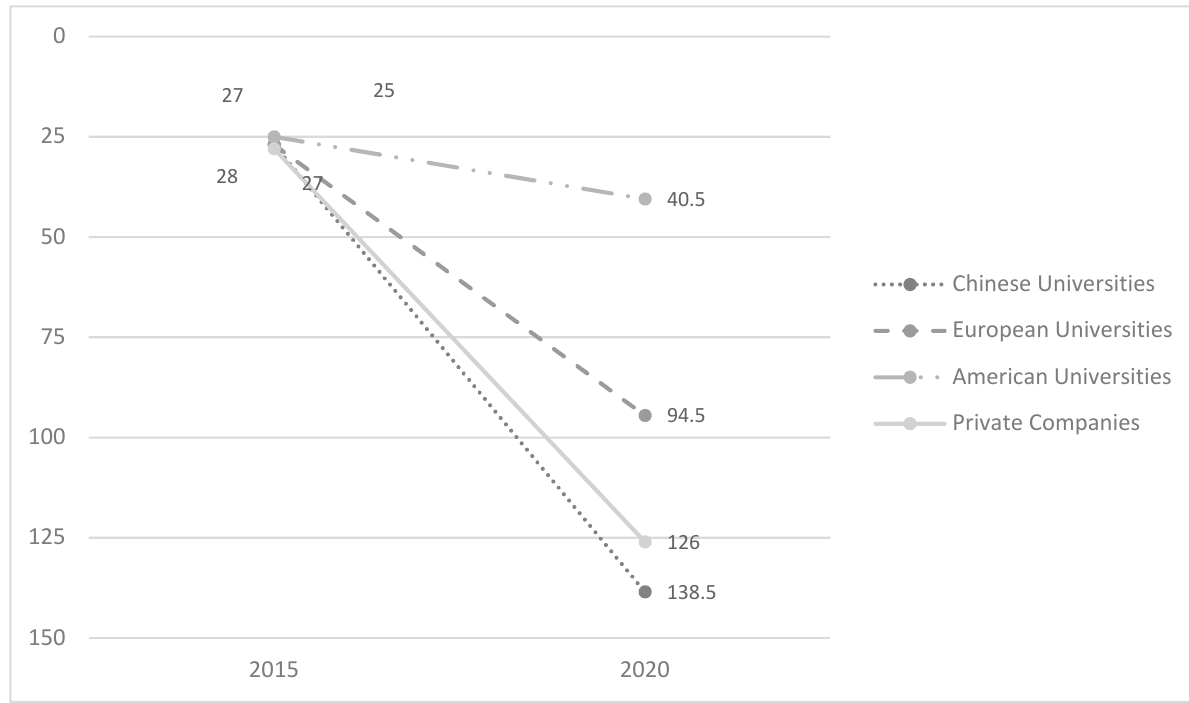
Figure 4. Trends 2010–2020 in sub-indicator “Sociality” in the best 30 universities of China, the European Union, the US, and in private companies. Table 7. Trends between groups 2010–2020 in sub-indicator “Sociality” in the best 30 universities of China, the European Union, the US, and in private companies.